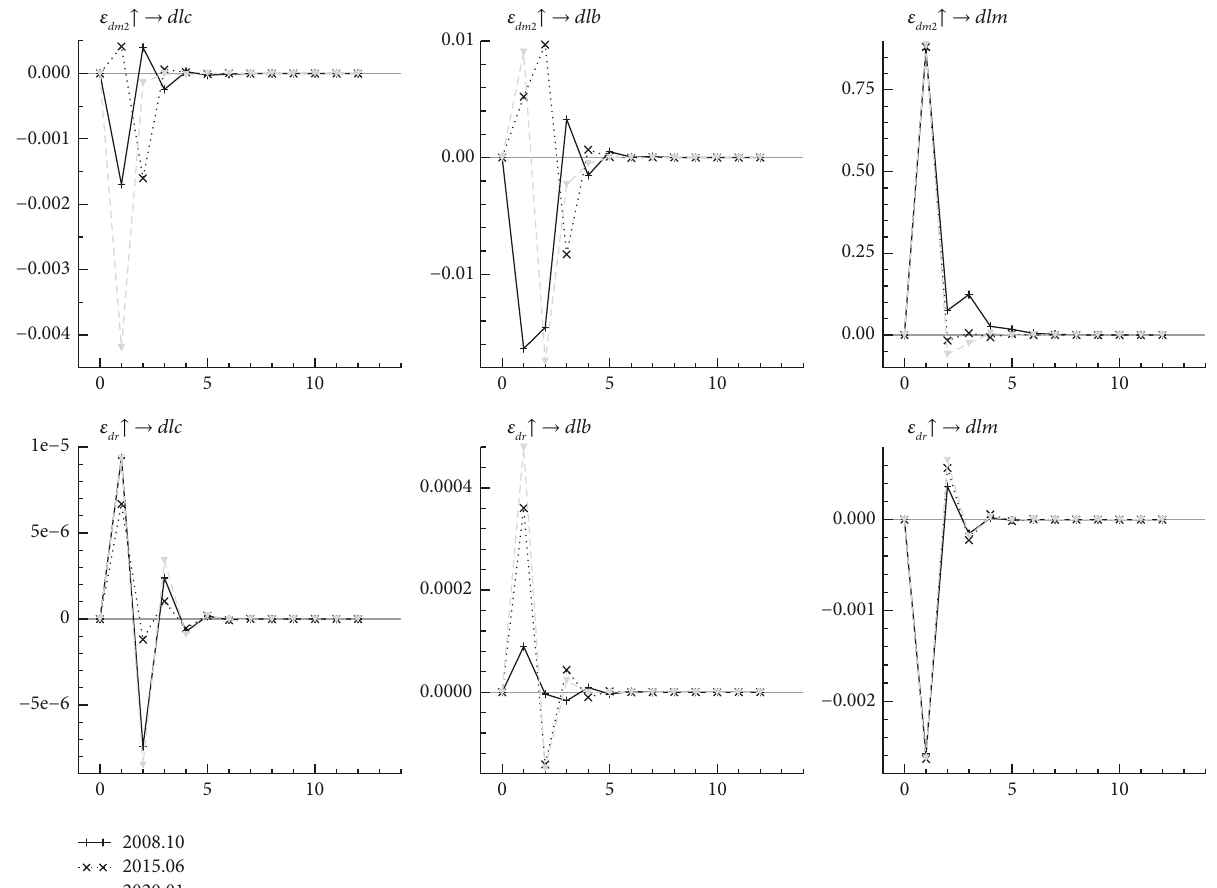
Figure 11: Impulse responses of monetary policy to liquidity at different time